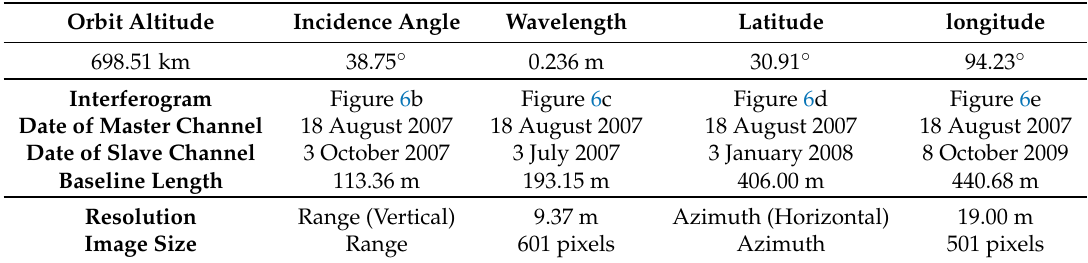
Table 5. Major Interferometric Parameters of Employed Real MB Dataset of ALOS PALSAR.